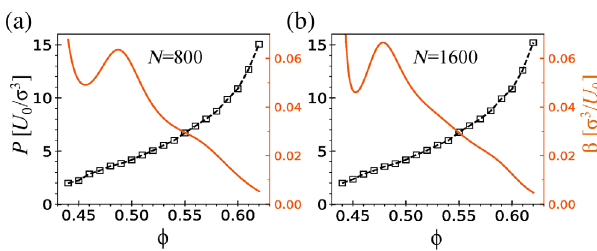
FIG. 13. EOS P ð ϕ Þ (squares) and compressibility β (red curve) for the 3D binary systems with N ¼ 800 (a) and 1600 (b)